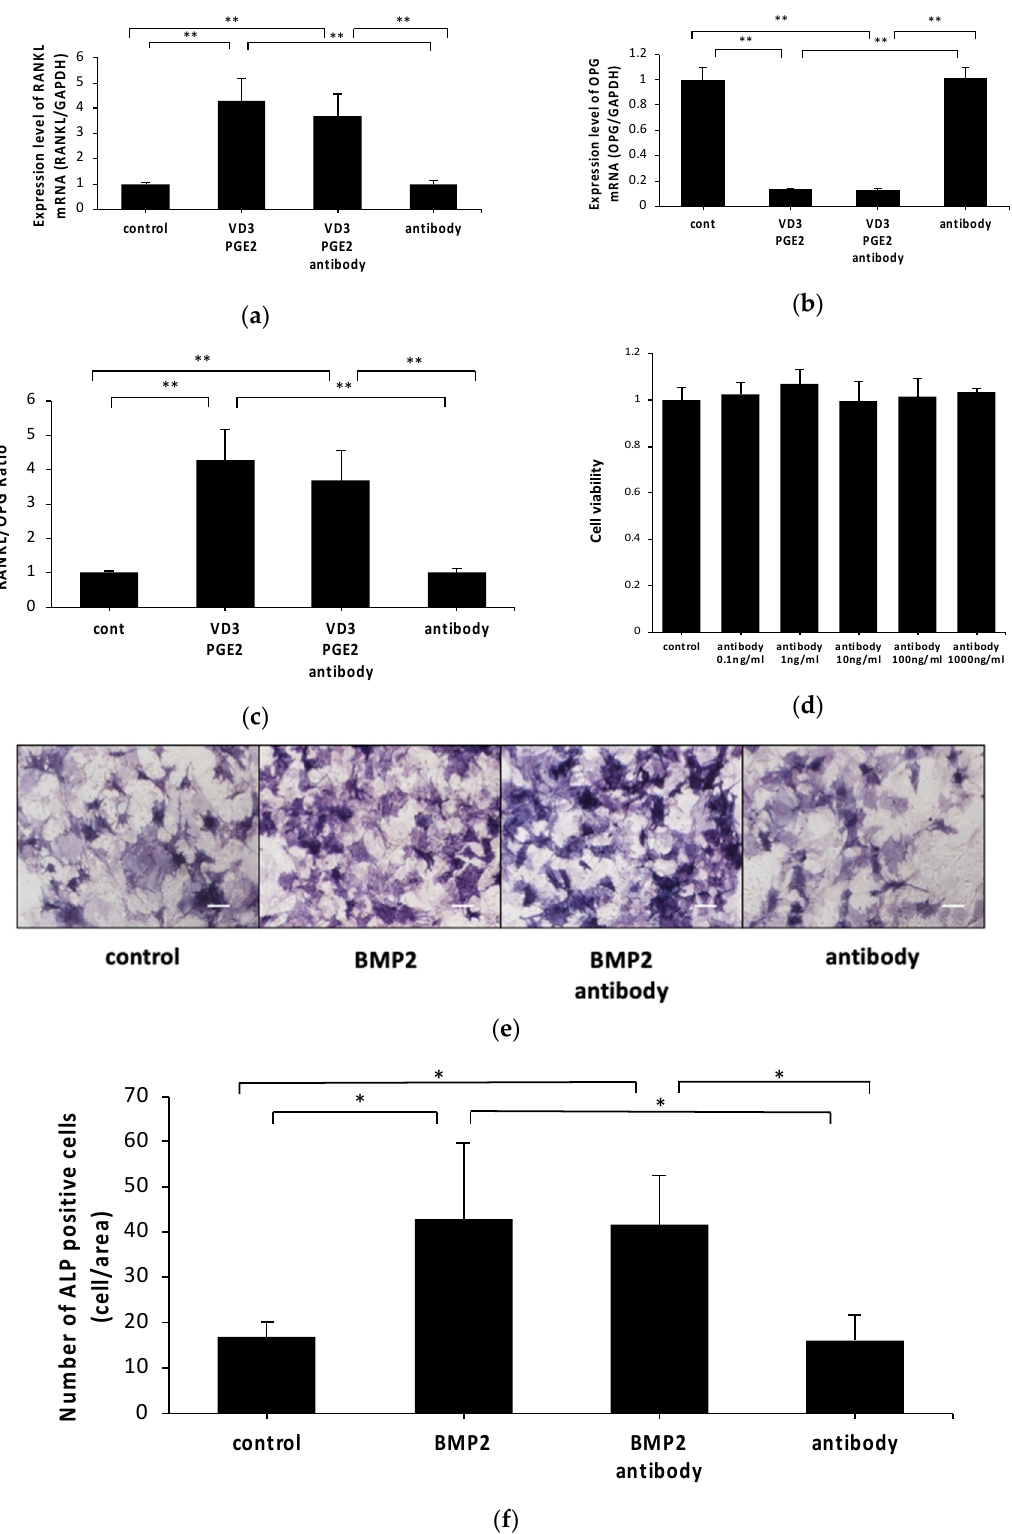
Figure 2. Anti-c-fms antibodies do not alter 1,25(OH) 2 D 3 and PGE2-affected RANKL OPG mRNA levels, cell viability or osteogenic differentiation in osteoblasts. ( a ) Levels of RANKL and ( b ) OPG mRNA in osteoblasts treated with PBS, 1,25(OH) 2 D 3 and PGE2, 1,25(OH) 2 D 3 and PGE2 in the presence of anti-c-fms antibody (100 ng/mL), or anti-c-fms antibody (100 ng/mL) alone analyzed by real-time PCR. Levels of RANKL and M-CSF mRNA were normalized to those of glyceraldehyde 3-phosphate dehydrogenase (GAPDH). ( c ) OPG/RANKL ratio in osteoblasts. ( d ) Cell viability of osteoblasts